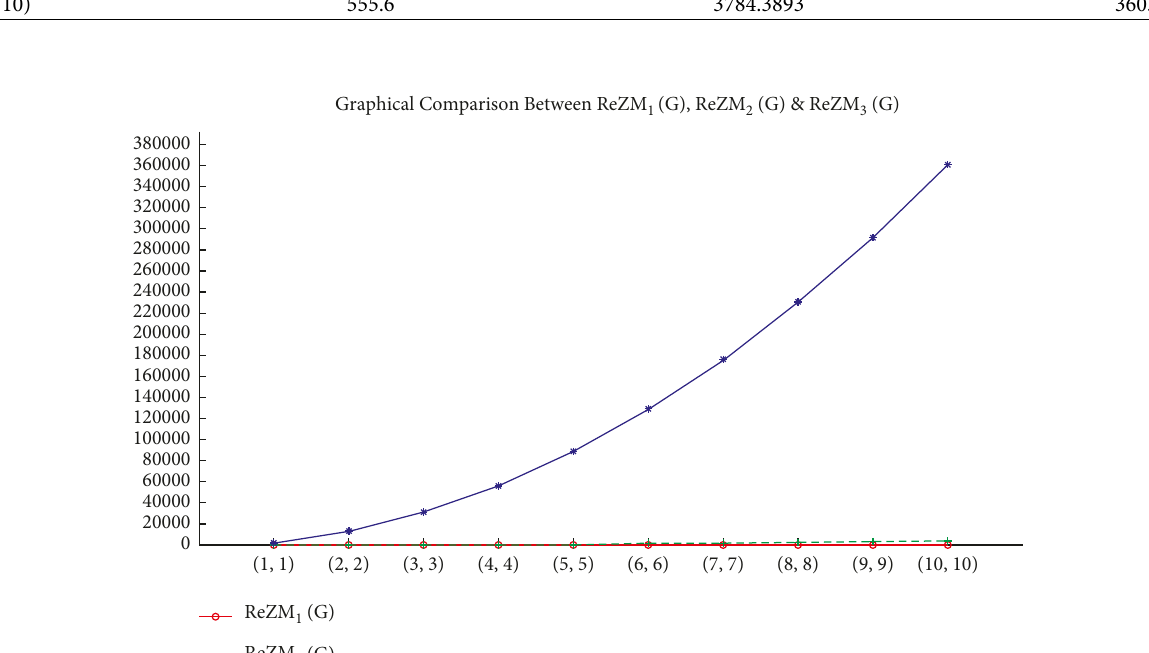
, Re ZG , and Re ZG 1 2